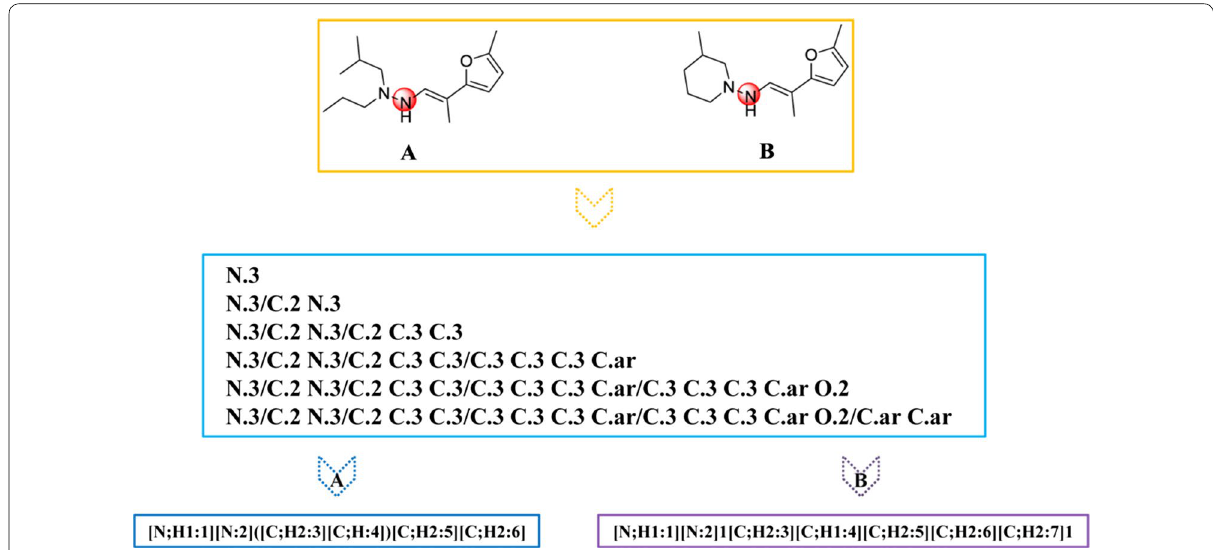
Fig. 7 Illustration of the role of detailed reaction SMARTS pattern. The Molprint2D fingerprints of two N atoms that marked with red circle in compound A and B are the same, while the chemical environment of those two N atoms are dissimilar. The reaction SMARTS pattern is employed to make up the intrinsic defects of Molprint2D fingerprints, such as unable to identify the ring structures, therefore, those two N atoms are distin- guished by different detailed reaction SMARTS patterns